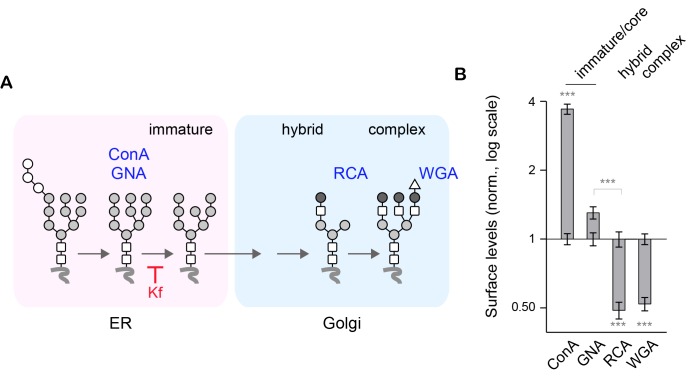
Blocking the maturation of core-glycans with kifunensine increases the surface levels of ConA- and GNA-reactive glycans but decreases RCA- and WGA-reactive glycans.(A) Simplified representation of the N-glycosylation pathway and site of action of kifunensine (Kf). (B) Surface levels of ConA-, GNA-, RCA- and WGA-reactive glycans in neurons (DIV 14–18) treated with Kf (5 μM) for two or three days. Shown are values in neurons treated with Kf normalized to control values (log 2 scale). Kf increases ConA and GNA levels but decreases RCA and WGA. N=53–81 cells in 2 experiments for each drug. ***p<1x10−4; Dunn’s multiple comparison test.